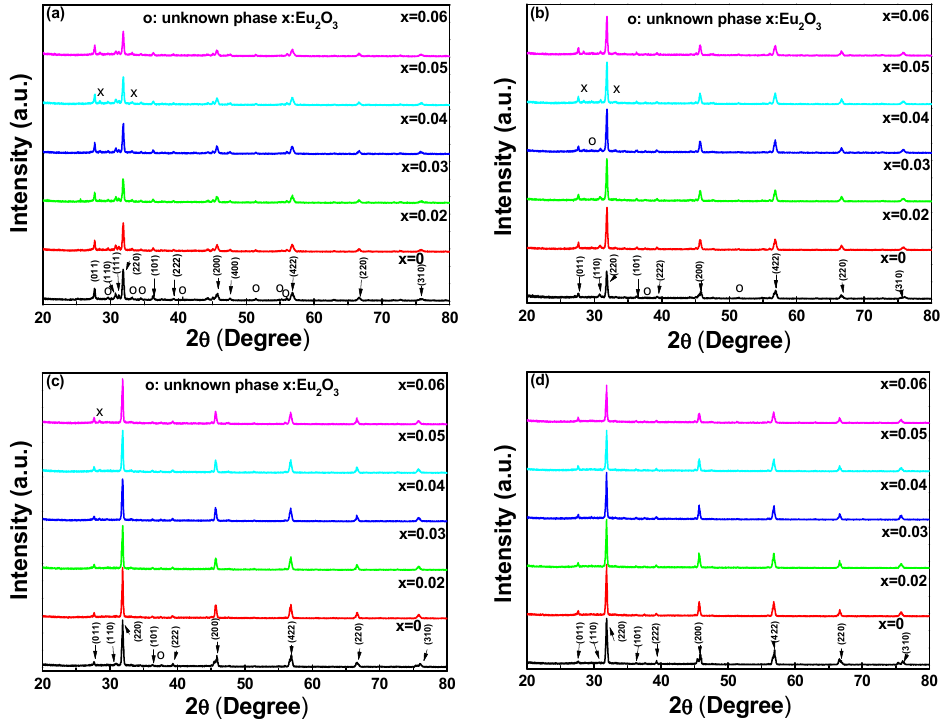
Figure 1. XRD patterns of Sr 2 − x Eu x ZnMoO 6 phosphors synthesized at ( a ) 900 °C; ( b ) 1000 °C; ( c ) 1100 °C; and ( d ) 1200 °C for 4 h, respectively.